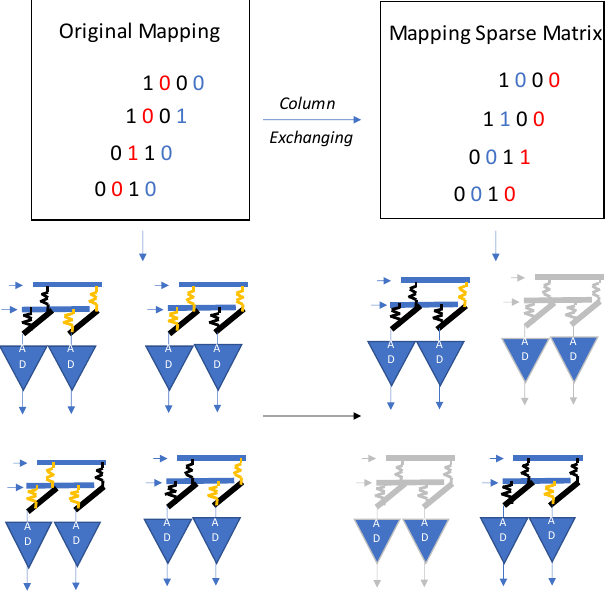
Figure 21. Sparse NN-based mapping scheme [24].